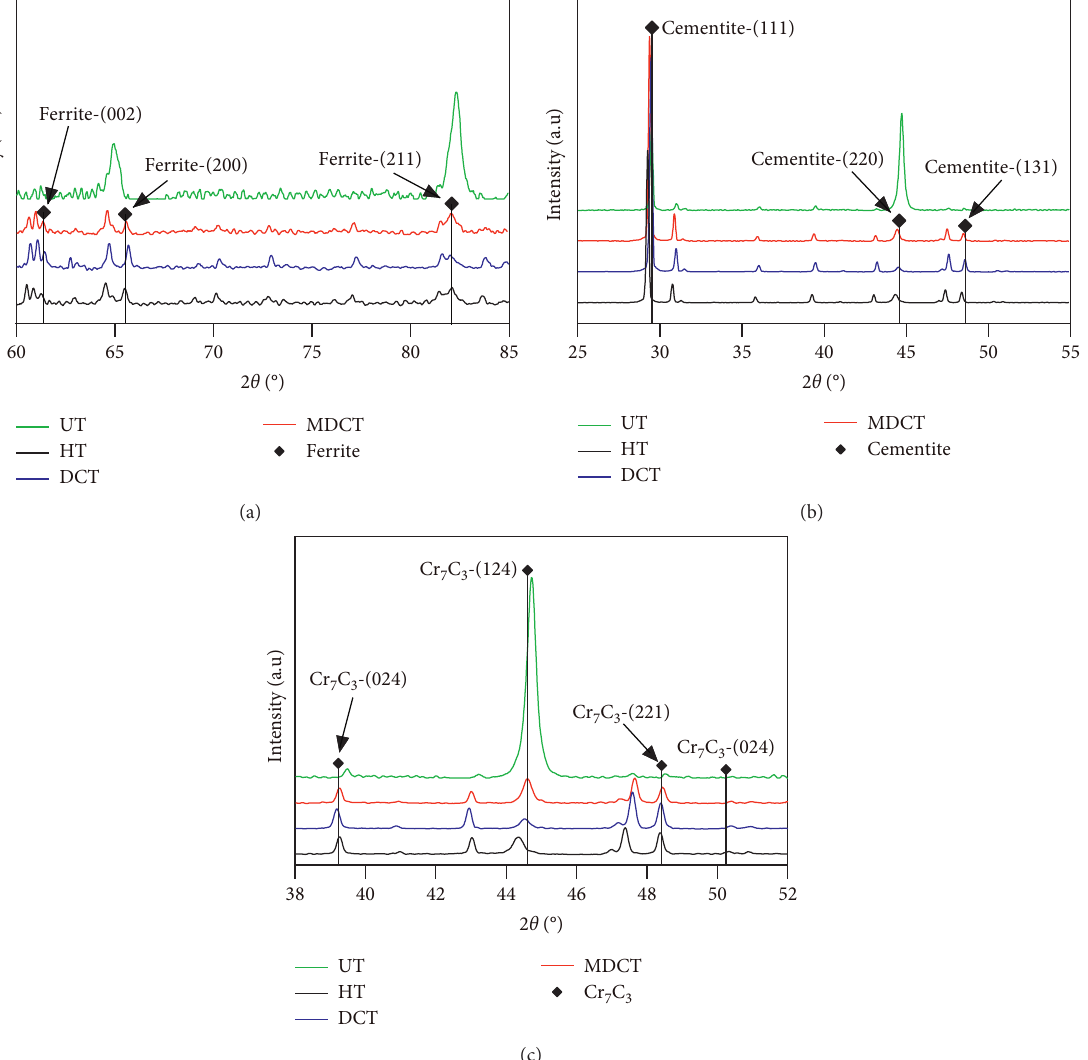
Figure 7: XRD pattern of process groups: (a) ferrite, (b) cementite, and (c)